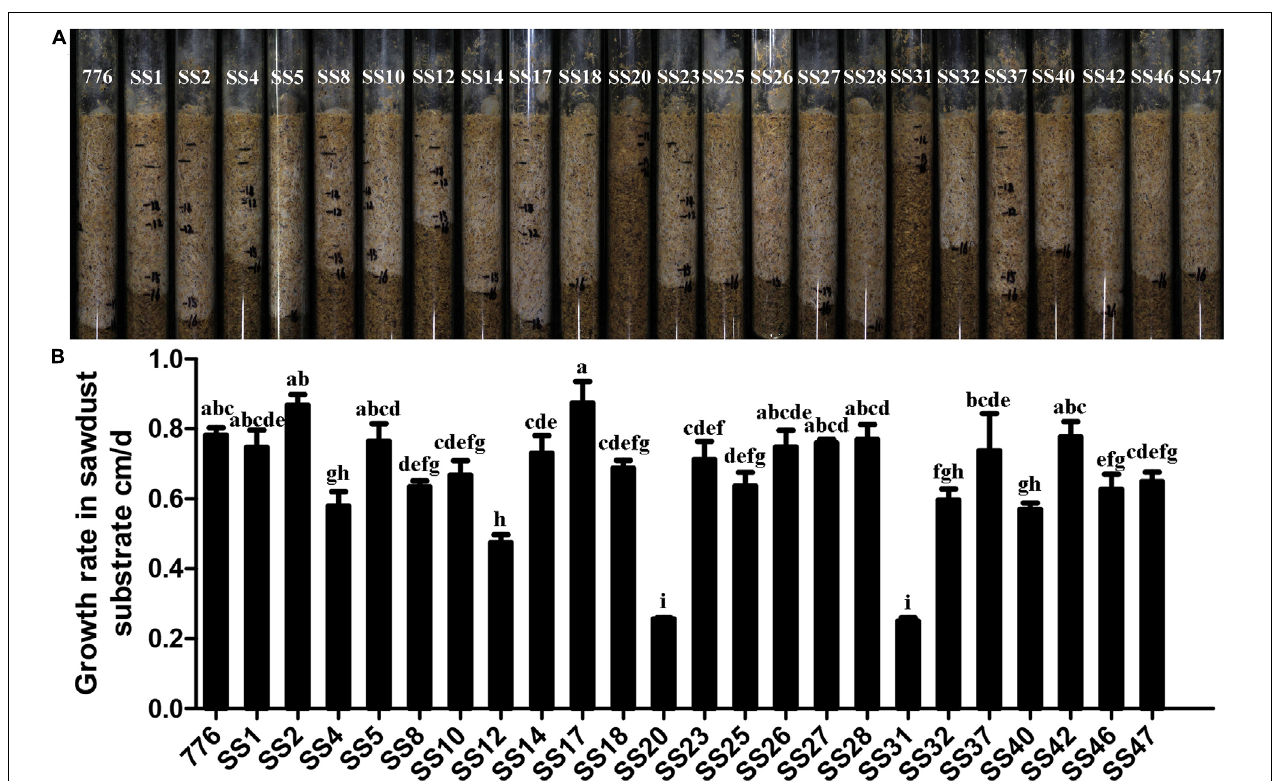
FIGURE 4 | Growth in sawdust substrate of different SSIs and parent strains. (A) Growth condition of the sawdust substrate. (B) Growth rates in the sawdust substrate. Values with different letters above the bars were significantly different ( p < 0.05) by Duncan’s multiple range